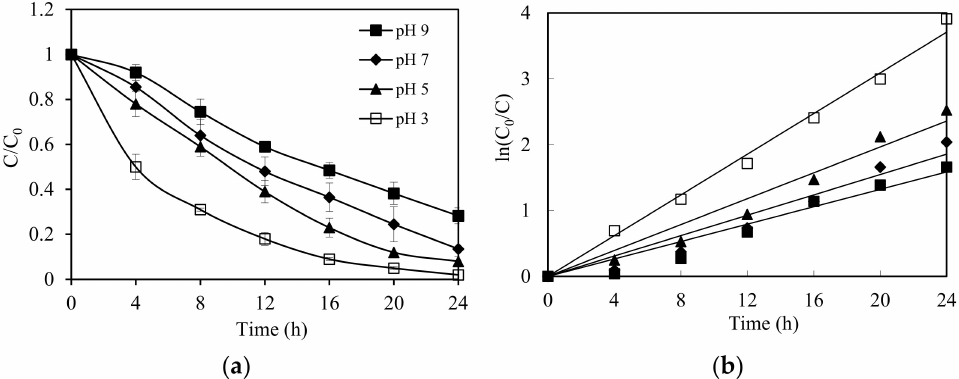
Figure 6. ( a ) pH effect on the photocatalytic degradation rate of ethiofencarb. Experimental conditions: ethiofencarb con- centration 10 mg L − 1 ; SnIn 4 S 8 concentration 0.5 g L − 1 . ( b ) Photodegradation kinetics of ethiofencarb in the SnIn 4 S 8 /visible system. Table 1. Photodegradation kinetics parameters (rate constants and linear regression coefficients R 2